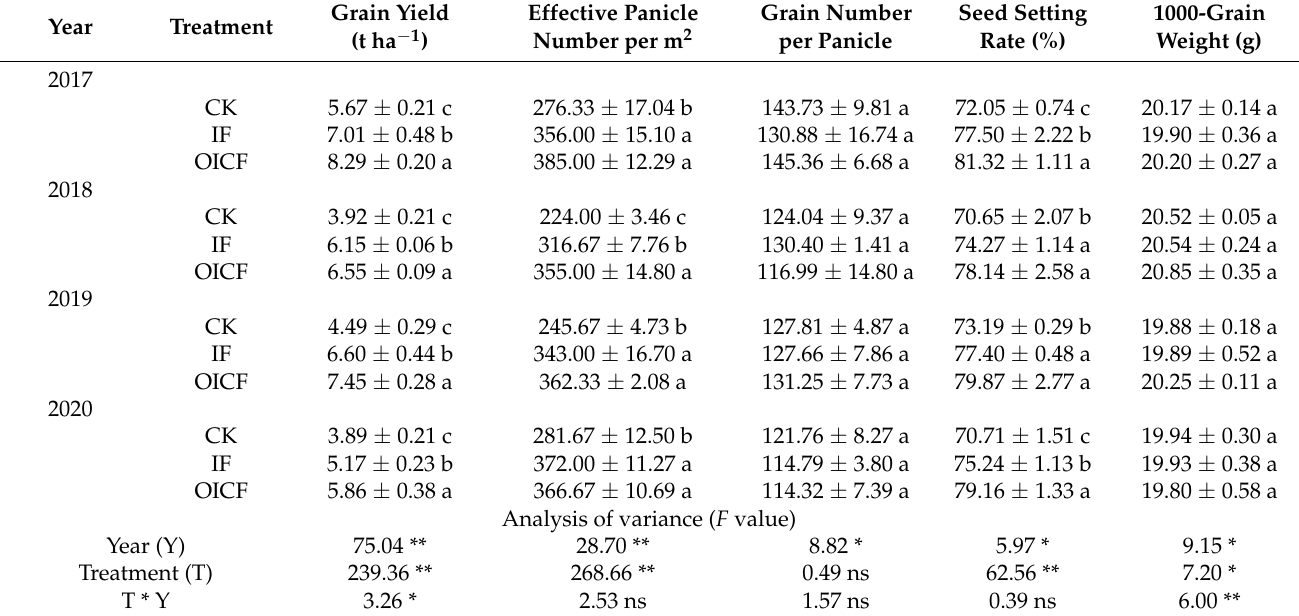
Table 1. Effects of new organic-inorganic compound fertilizer on grain yield and yield-related traits of fragrant rice.